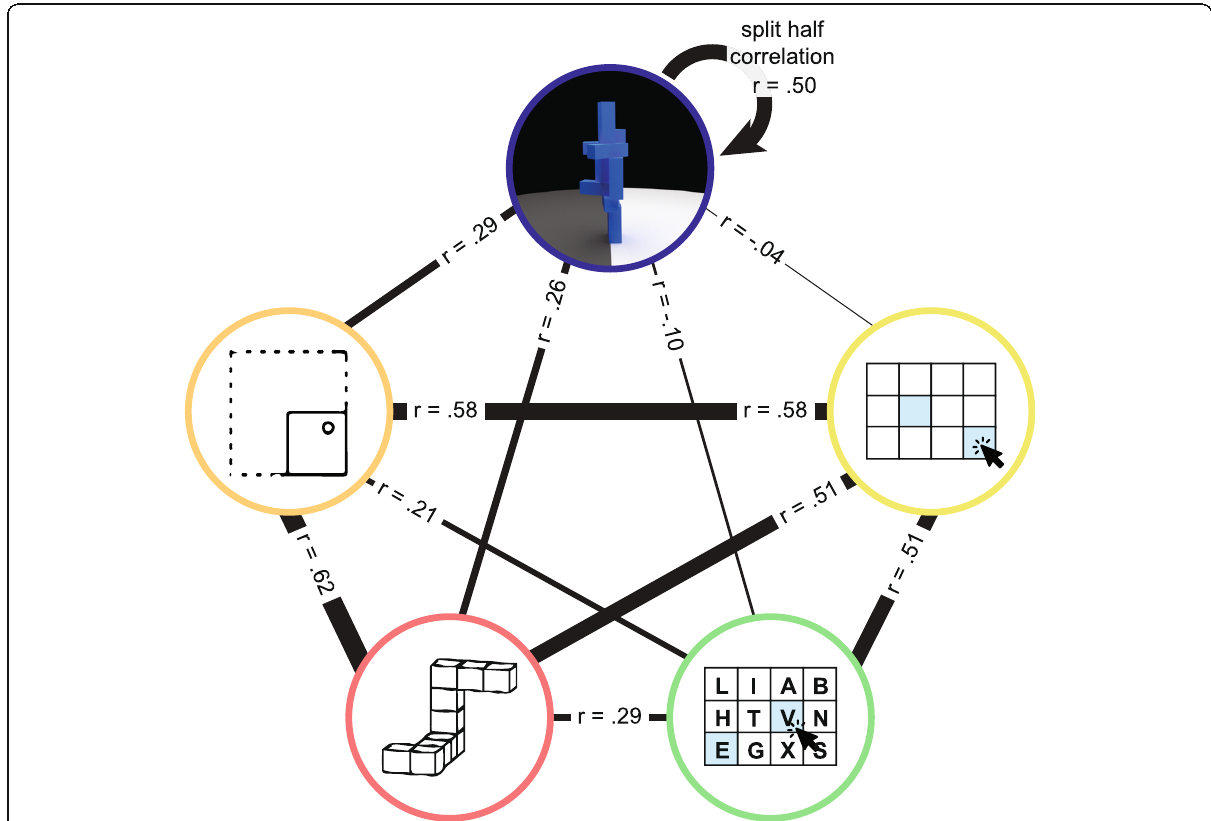
Fig. 3 Relationships in participants ’ performance among all tasks. Each color-coded circle represents one task. From the top counter-clockwise: Unstable Towers Task, Paper Folding Test, Mental Rotation Test, verbal working memory task, spatial working memory task. The width of each connecting line is scaled to represent the strength of the correlation between individual differences on each pair of tasks. All r values are from Pearson correlation tests in 100 participants. All correlations were statistically significant at an alpha level of .05 except for the comparisons of the Unstable Towers task to the verbal and spatial working memory tasks, for which the p values were both greater than 0.3. While performance on the Unstable Towers task was significantly correlated with performance on each of the spatial cognition measures, the split-half reliability of the towers task was greater than its correlation with either spatial